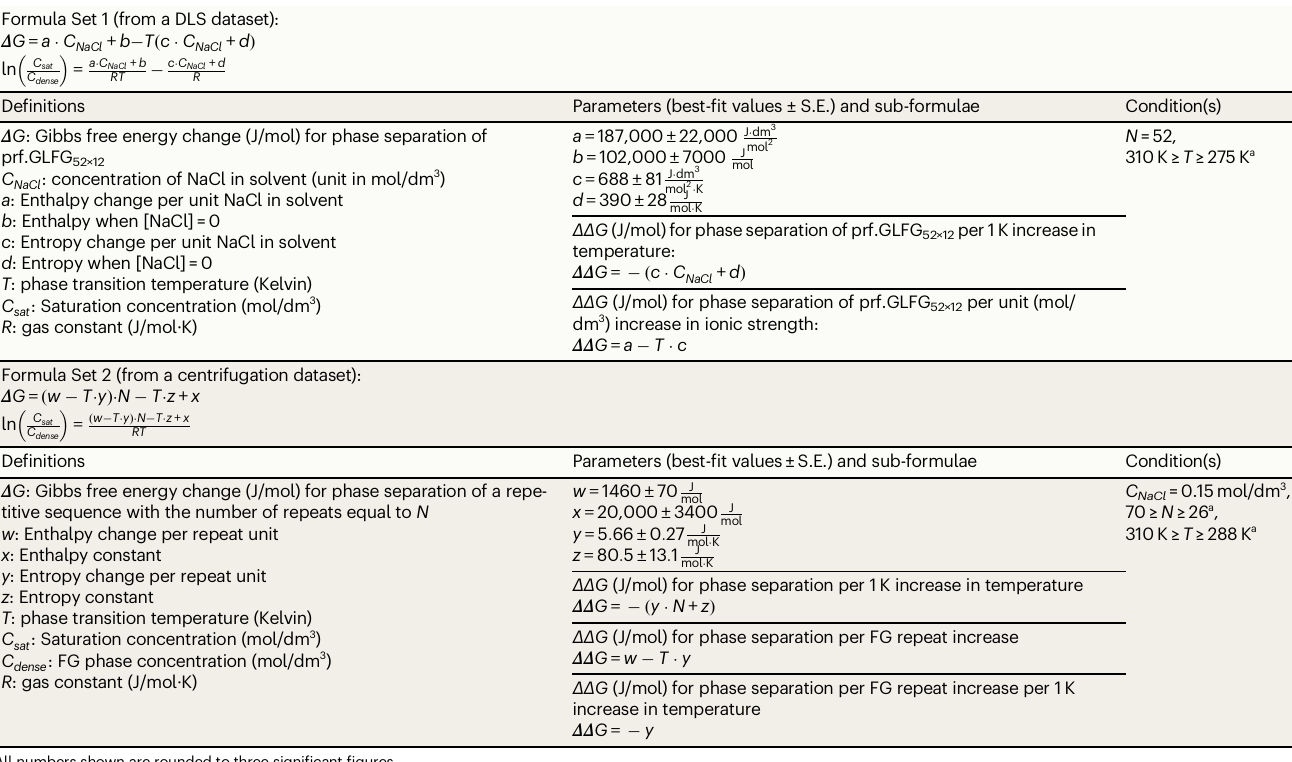
Table 1 | Formulae and parameters derived in this study Formula Set 1 (from a DLS dataset): (cid:1) T ð c (cid:3) C Þ Δ G = a (cid:3) C (cid:4) NaCl + b NaCl + d ln C sat C dense